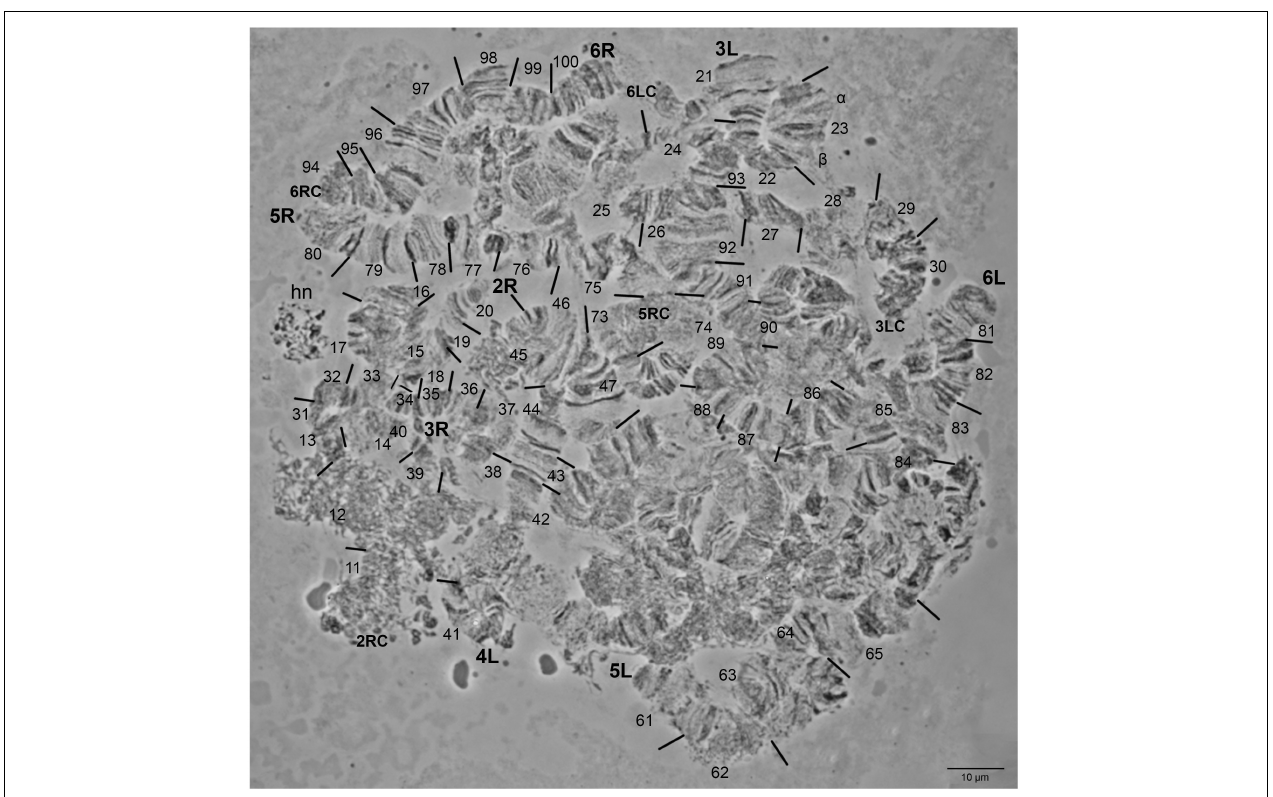
FIGURE 2 | Zeugodacus tau salivary glands cells polytene nucleus. The tips of chromosome arms 2R, 3L, 3R, 4L, 5L, 5R, 6L, and 6R are indicated. Numbered divisions are shown, separated by lines. hn: heterochromatic network. 2RC, 5RC, 6LC, 6RC: centromeric regions of 2R, 5R, 6L, 6R arms,